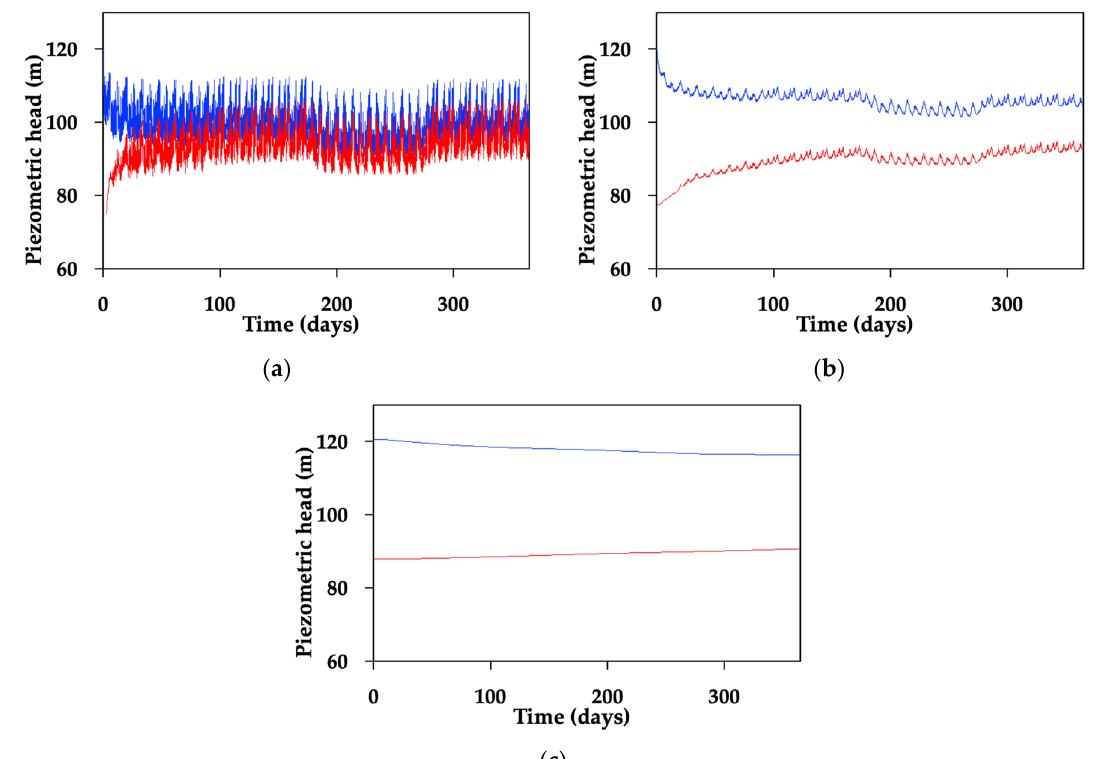
Figure 6. Piezometric head evolution at three observation points located at the upgradient side of the underground reservoir and at 105 m depth. Results of F-CI scenario are displayed in blue while those of E-CI scenario are plotted in red. The observation points are located at 5 ( a ), 15 ( b ) and 100 m ( c ) from the underground reservoir. The piezometric head is calculated taking as reference the bottom of the model, thus, the units are meters above the bottom of the model.